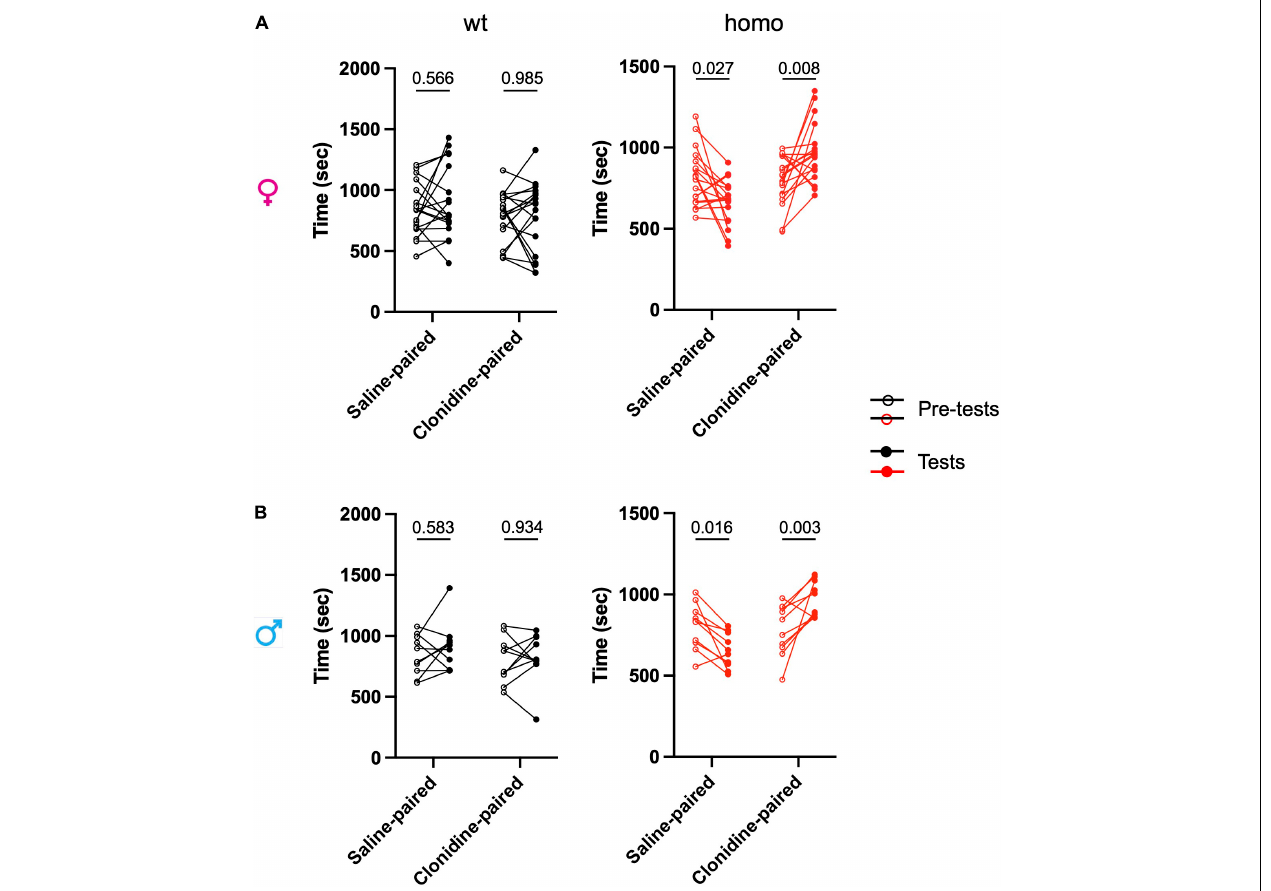
FIGURE 6 | Scn9a R 185 H mutant mice show spontaneous ongoing pain. Ongoing pain was assessed in a conditioned place preference test. After pre-test/habituation for chamber preference on days 1 to 3, conditioning was made on day 4 by intrathecal treatment with either saline solution in the morning or clonidine solution in the afternoon with a restriction in one chamber. On day 5, the animals were free to explore the chambers and the time spent in each chamber was recorded for 30 min. (A) Females. (B) Males. The time spent in each chamber before conditioning (pre-test) and after conditioning with clonidine or saline (test) are shown. Homozygous mice of both sexes spent more time in clonidine-paired chamber while wt mice spent on average equal time in saline-paired and clonidine-paired chambers. Dots represent individual data points. females: wt, n = 18; Homo, n = 18; males: wt, n = 10; Homo, n = 10. Two-way ANOVA for treatment and trial (pretest and test) on each genotype and sex group, Sidak’s multiple comparison test. P = values for comparing pre-test and test values are shown. Refer to Supplementary Table 12 for